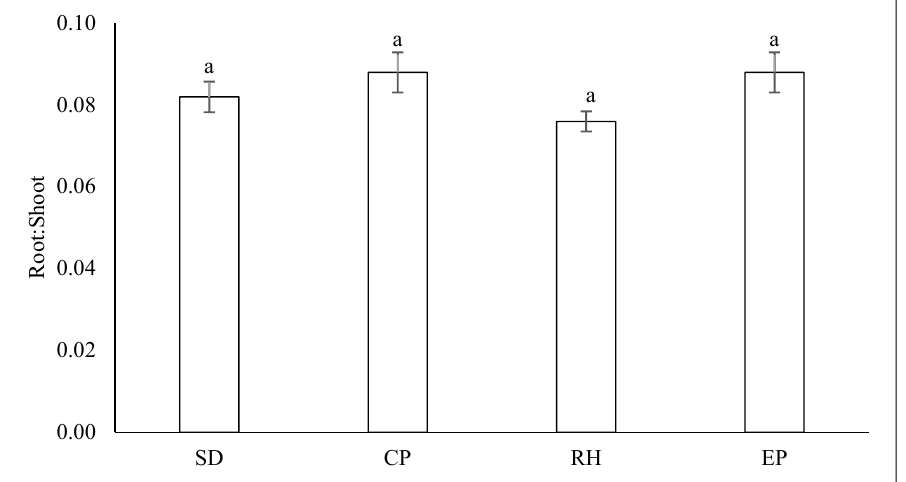
Figure 4. Dry root to shoot ratio of lettuce under different growing media. Abbreviations are as follows for substrate mixtures of cocopeat: sawdust: rice husk in the following proportions: 1:3:1 (SD sawdust); 3:1:1 (CP cocopeat); 1:1:3 (RH rice husk); and 1:1:1 (EP equal proportions of all three organic substrates). Different letters in the same column indicate significant differences between treatments ( p < 0.05). Vertical bars indicate standard errors of means.